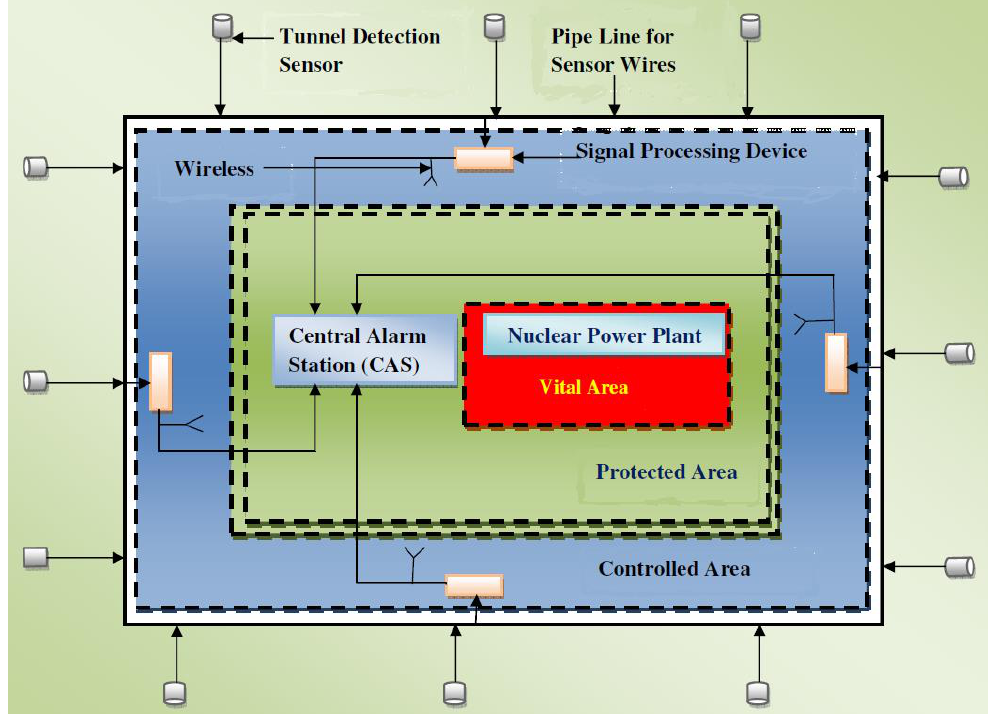
Figure 1.Graded approach for the tunnel threat detecting security